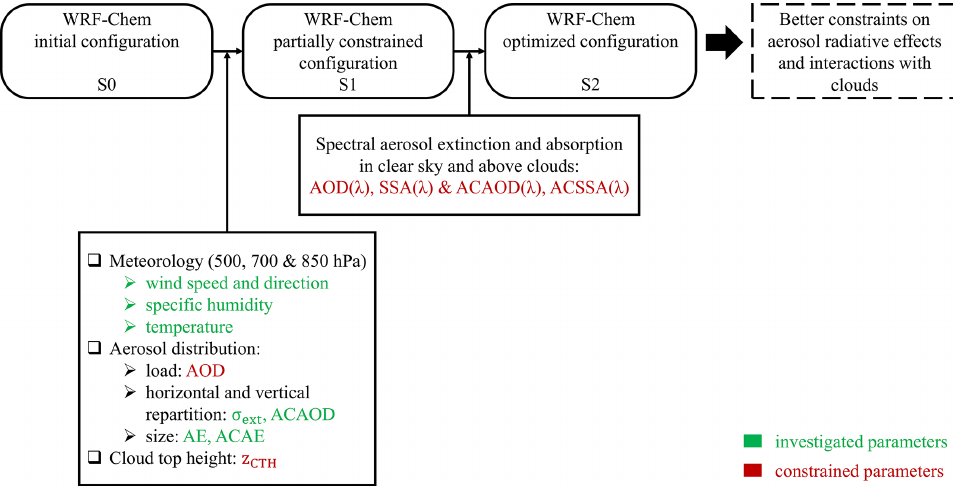
Figure 3. Schematic diagram of the general approach applied to constrain WRF-Chem simulations of aerosols using A-Train satellite co- incident retrievals of the distributions of aerosols and clouds. AOD, ACAOD, SSA, ACSSA, σ ext , AE, ACAE and z CTH stand for aerosol optical depth, above-cloud aerosol optical depth, single scattering albedo, above-cloud single scattering albedo, aerosol extinction coefficient, Ångström exponent, above-cloud Ångström exponent and cloud top height,